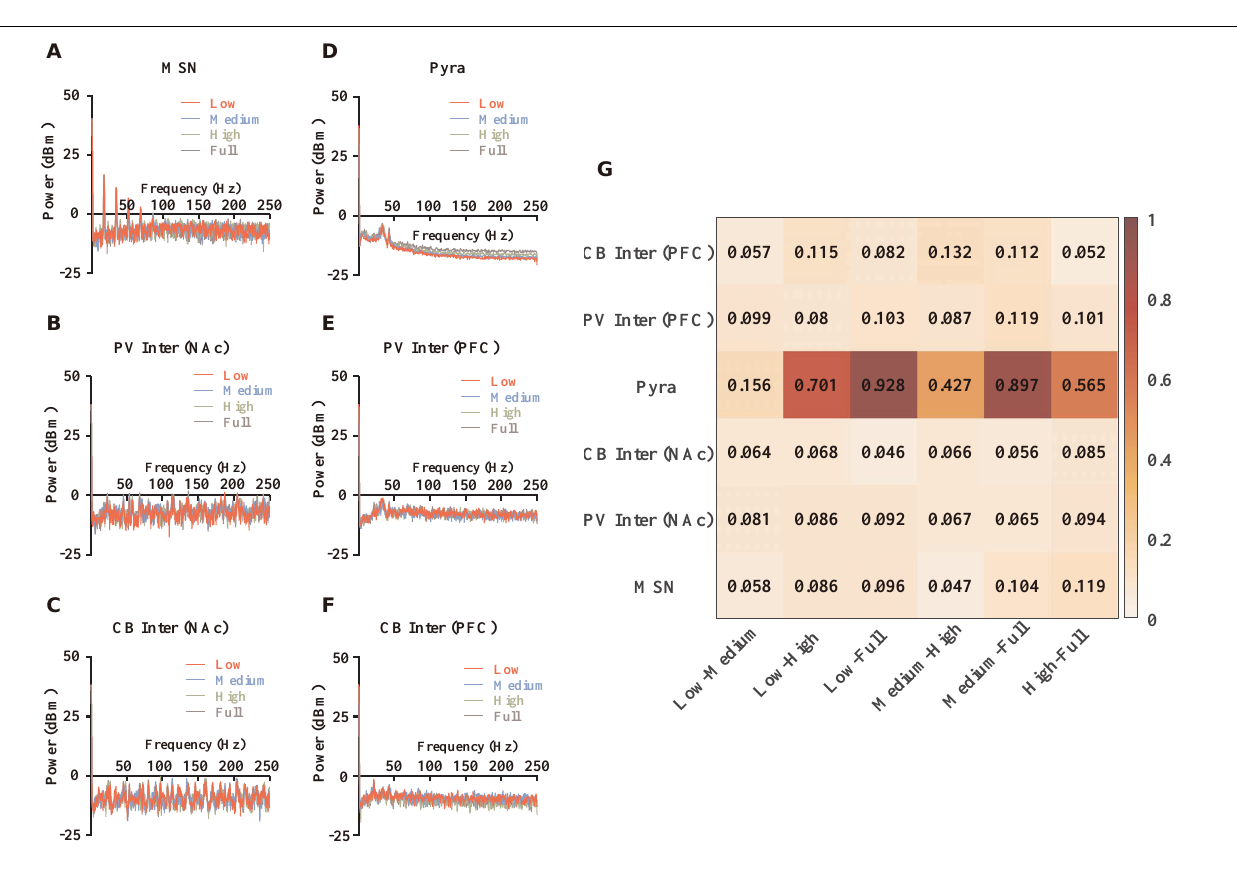
( Figure 7 ), calculated as (cid:49) P = P dBm , DA − P dBm , Control = 10 · ( P W , DA ) . Here, the blue part ( − 20 to 0 dBm/Hz) log 10 P W , Control